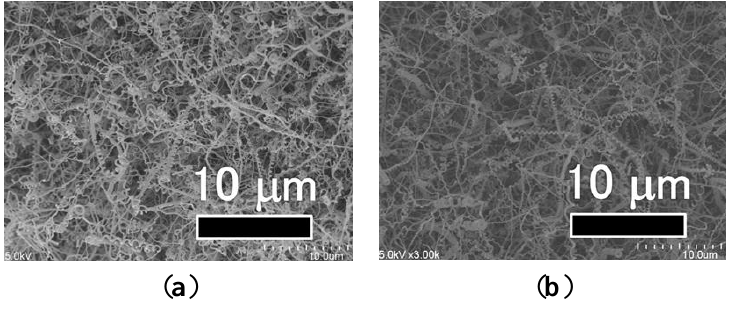
Figure 8. Cross-sectional SEM micrographs of carbon deposits grown with different catalyst structures: ( a ) Fe 2 O 3 /SnO 2 ; ( b ) SnO 2 /Fe 2 O 3 /SnO 2 ; and ( c ) SnO 2 /Fe 2 O 3 . The red and blue arrows represent the thicknesses of the CNC and carbon layers, respectively.